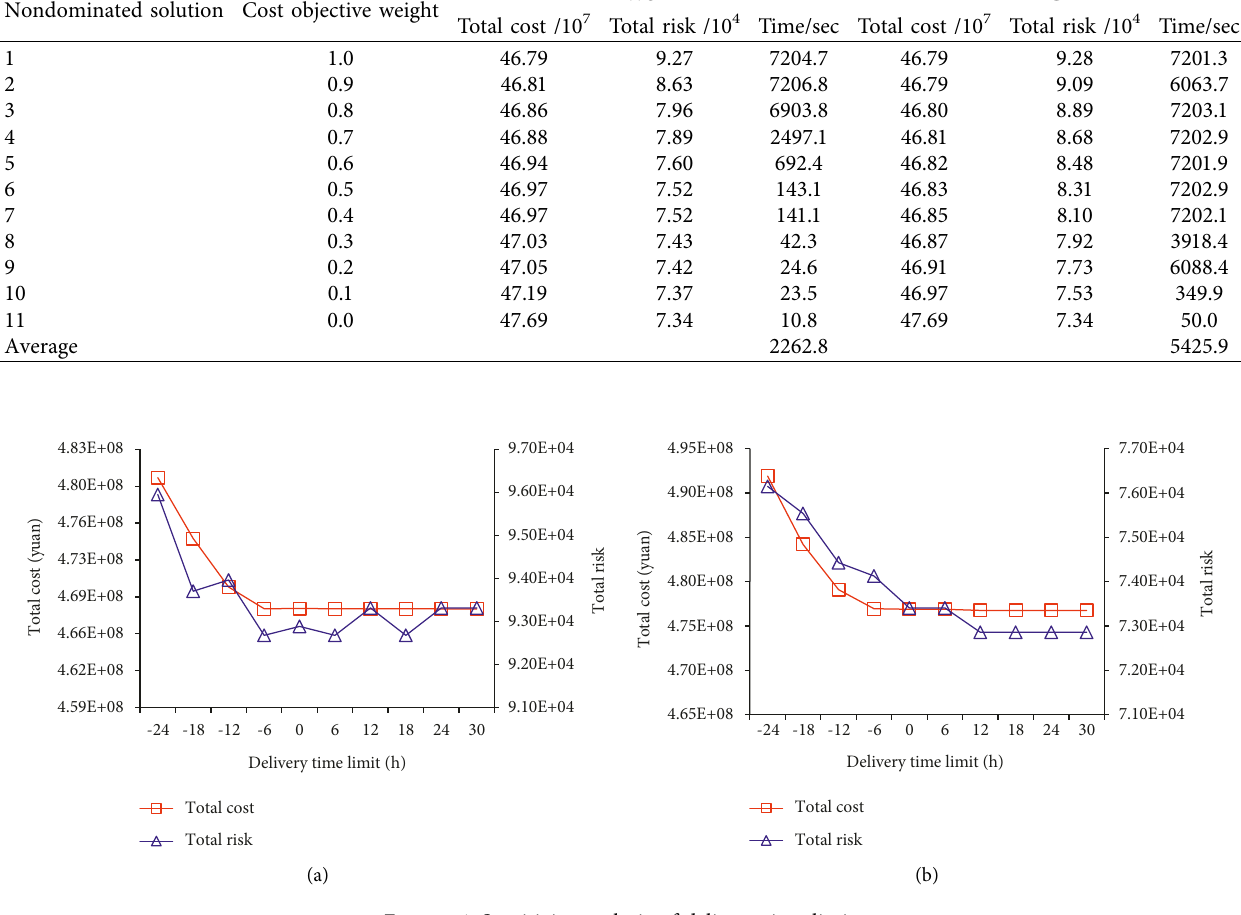
Figure 6: Sensitivity analysis of delivery time limit.